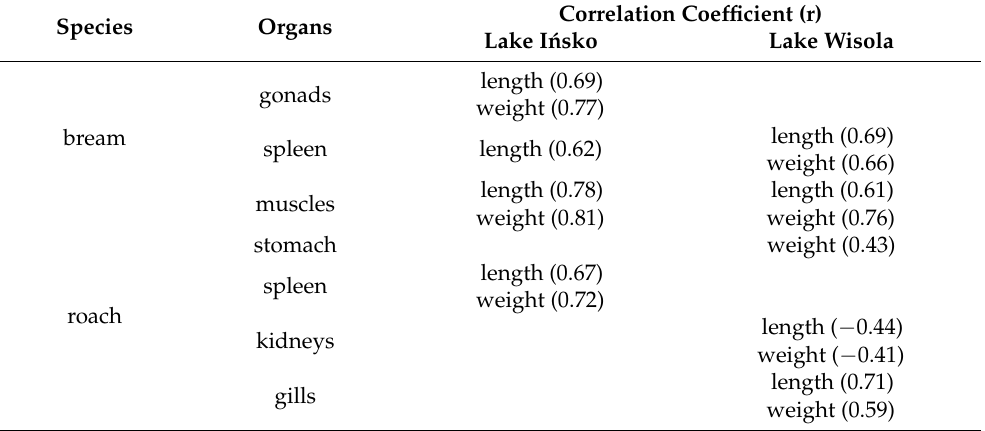
Table 7. Linear correlation coefficient (r) between mercury content in fish organs and fish size ( p < 0.05).